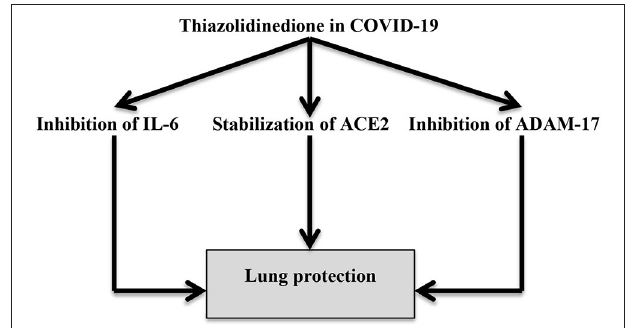
FIGURE 6 | Thiazolidinedione attenuates the pathogenesis of COVID-19 through inhibition of IL-6 and ADAM-17 with the modulation of ACE2, as thiazolidinediones can regulate the AngII-mediated